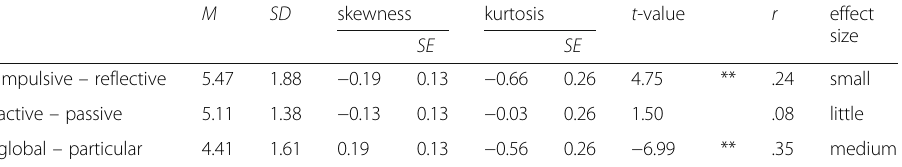
Table 4 Descriptive statistics and results of one-sample t-tests for the three extracted factors M SD skewness kurtosis